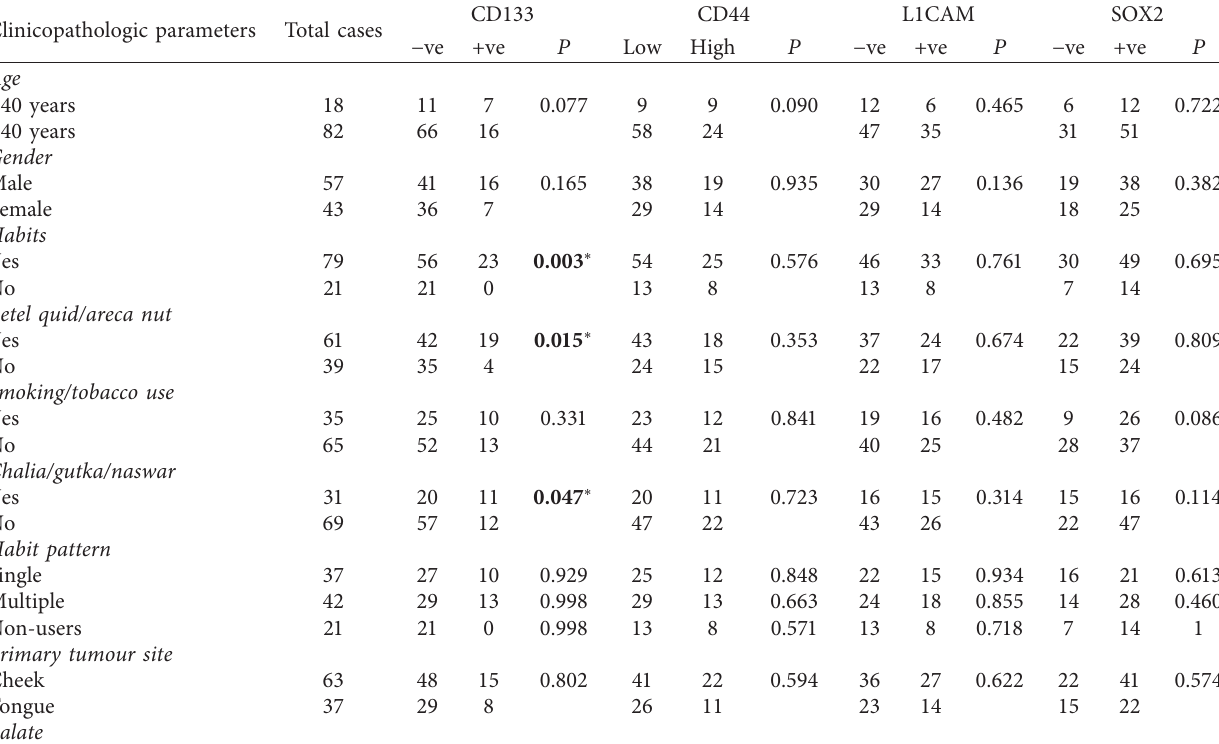
Table 4: Correlations of antibody expression and patient